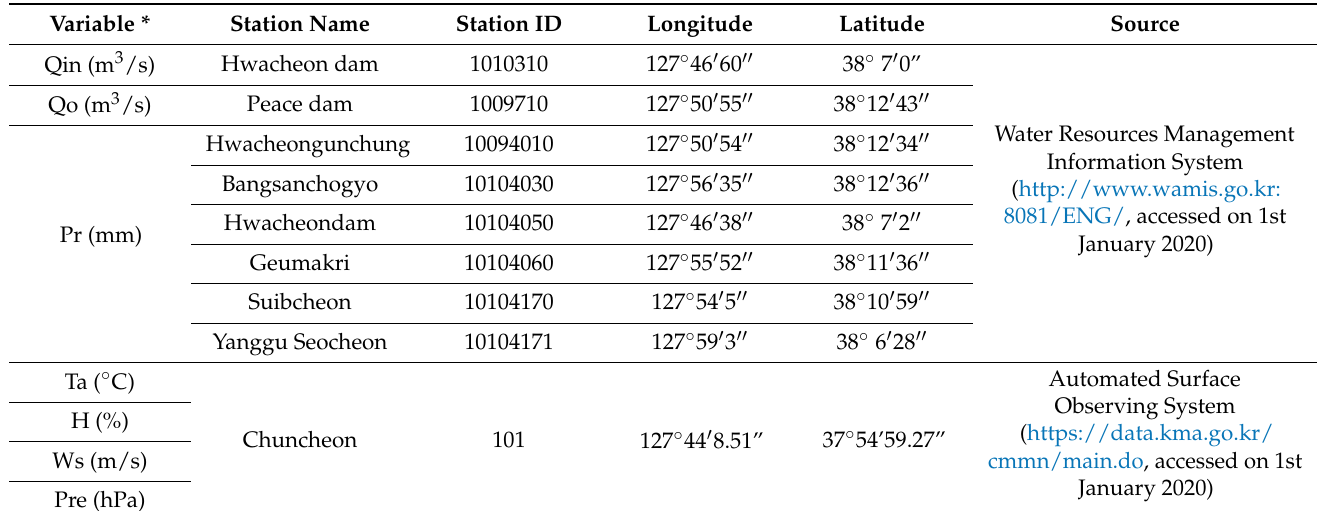
Table 3. Information about the data used for predicting the inflow of the Hwacheon